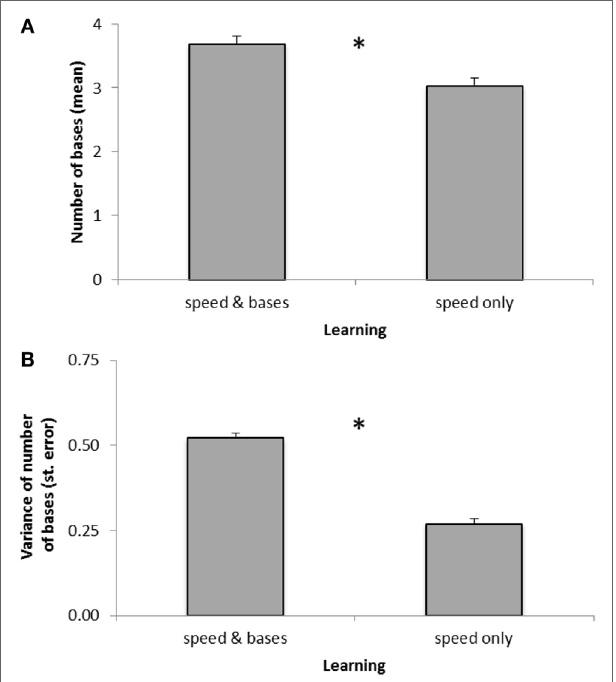
FIGURE 12 | Learning in the Tag game . (A) Number of bases that agents touched. With learning based on speed and number of bases, agents touched significantly more bases. (B) Variance in number of bases touched. With learning based on speed and number of bases, agents had significantly greater